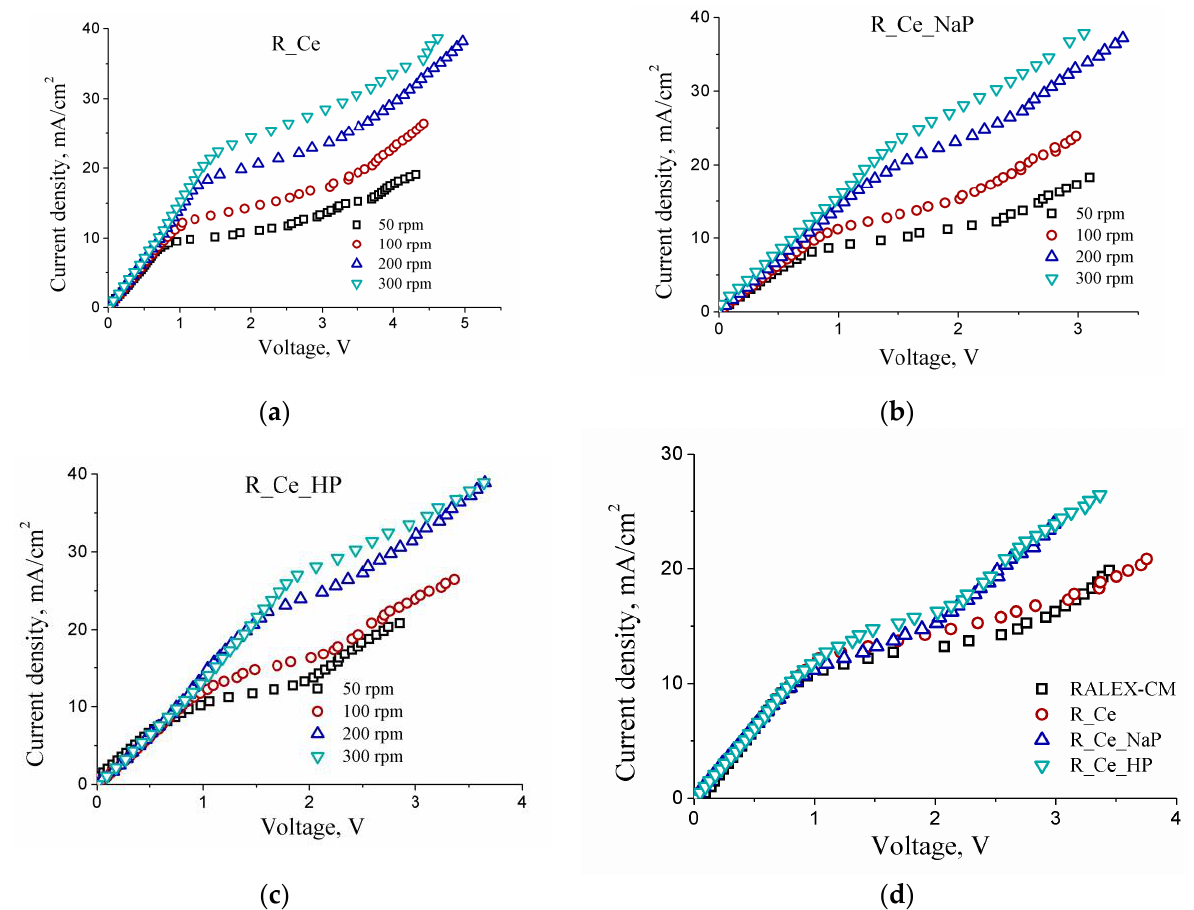
Figure 4. Current-voltage curves of the R_Ce ( a ), R_Ce_NaP ( b ) and R_Ce_HP ( c ) membranes in 0.03 mol-eq/L solution of NaCl and CaCl 2 at different membrane disc rotation rates, and the comparison of CV curves obtained at a membrane disc rotation rate of 100 rpm ( d ).